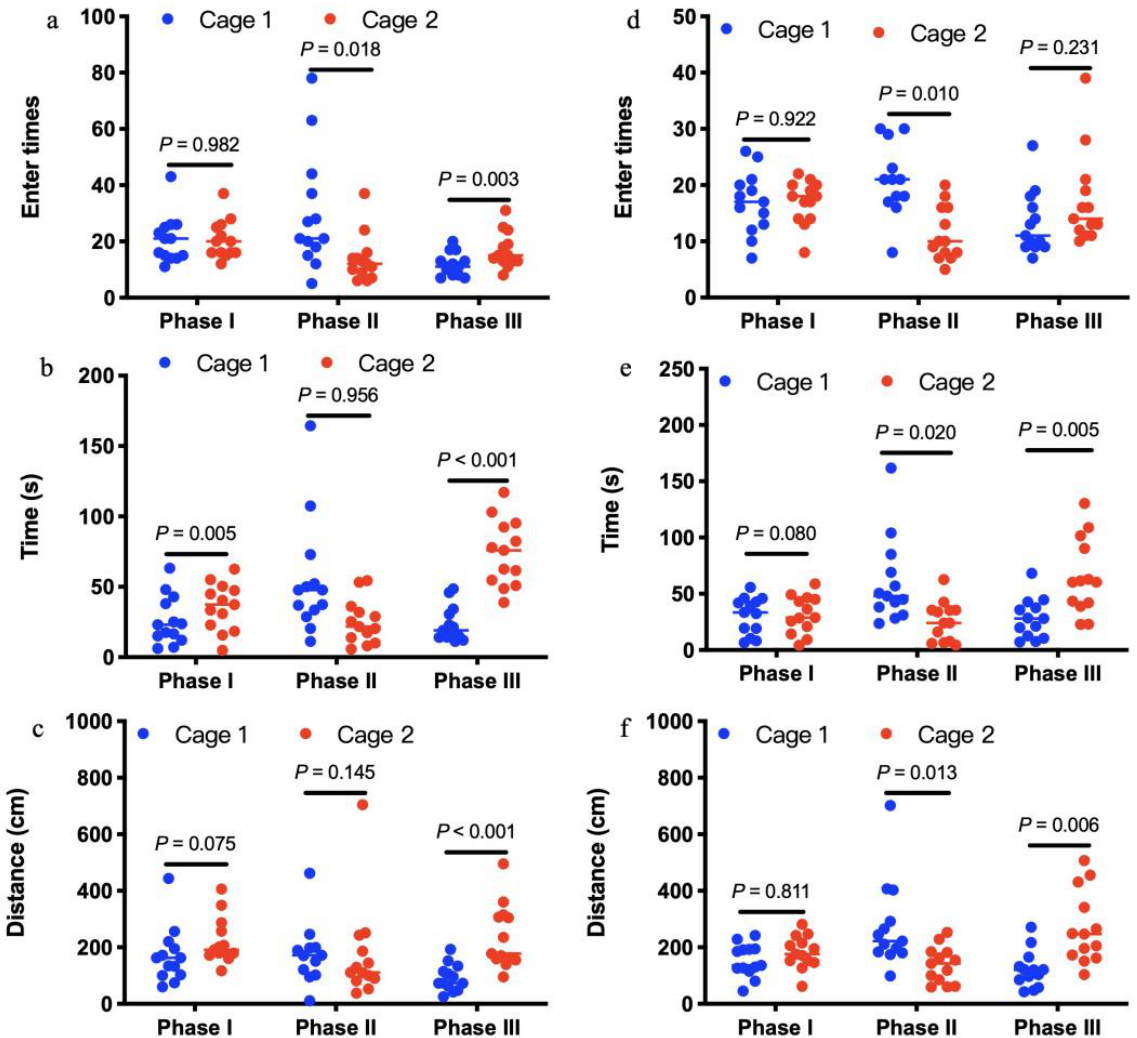
Figure 6. Social interactions of antibiotics-treated mothers ( a – c , n = 13) and controls ( d – f , n = 13). In the three-chambered sociability test, antibiotics-treated mothers exhibited similar sociability and preference for social novelty to controls, as seen from the entry times ( a , d ), the time spent sniffing (b and e), and the travel distances ( c , f ) in each chamber at phase I, II, and III.